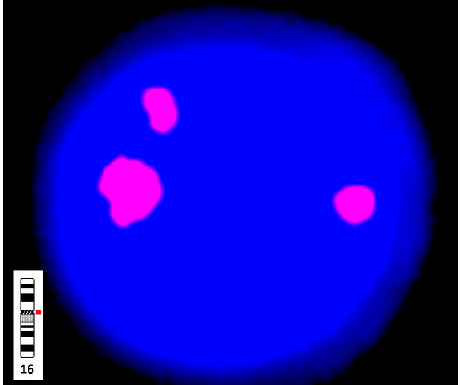
Figure 3. Interphase FISH analysis of cord blood performed at 28 weeks of gestation using Satellite Enumeration probes (Cytocell Inc. Adderbury, Oxfordshire, UK) confirmed a true fetal mosaicism of trisomy chromosome 16 (nuc ish(D16Z2×3)[40/200]). The probe specific for the centromere of chromosome 16 (D16Z2, corresponding to 16p11.1-q11.1) is labeled with red.